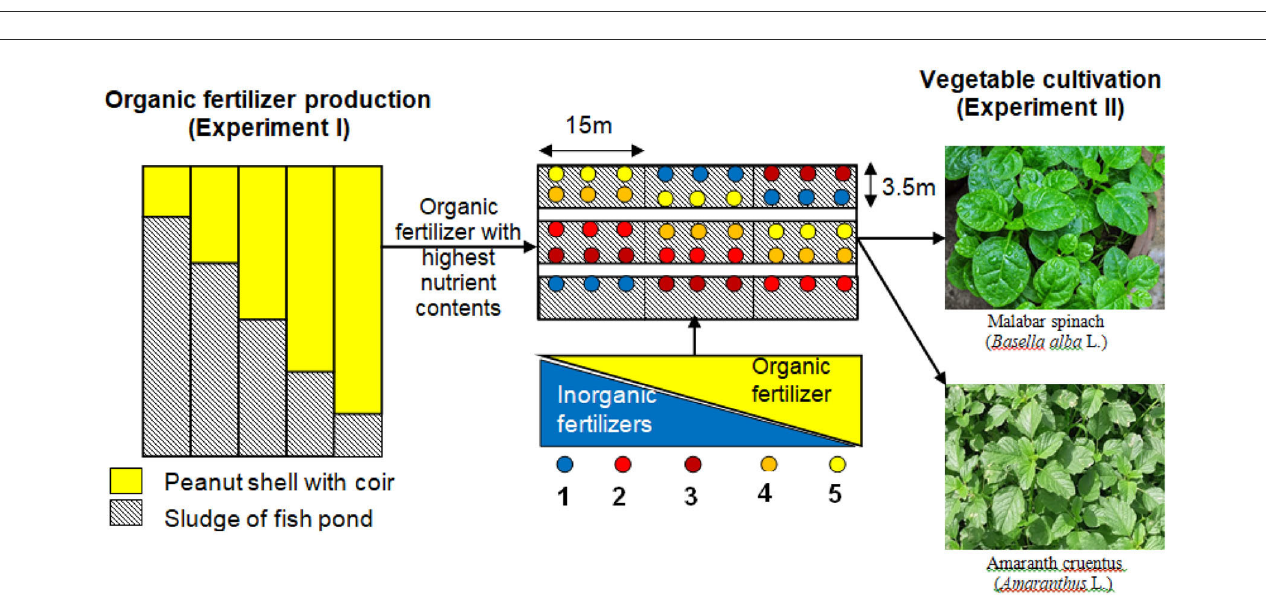
FIGURE1 Study area in Binh Duong province, Vietnam.